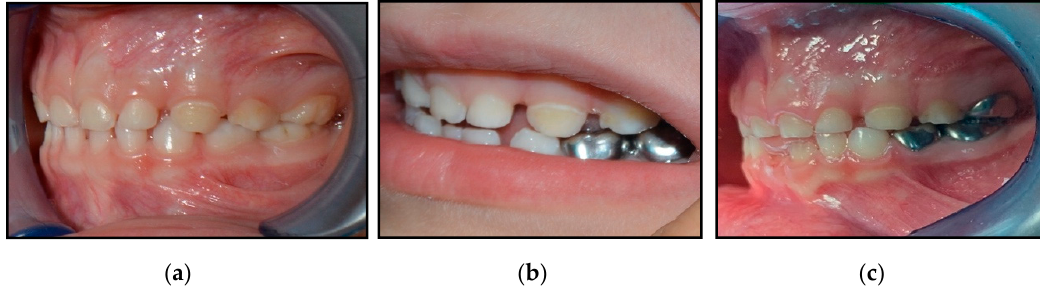
Figure 1. A four-year-old boy treated with Hall preformed metal crowns (PMCs) showing: ( a ) A pre-treatment lateral photograph showing the patient’s occlusion, ( b ) a post-treatment lateral photograph showing the patient’s occlusion (taken immediately after cementation of the last PMC), and ( c ) a one-year-recall photograph showing correction of the OVD.